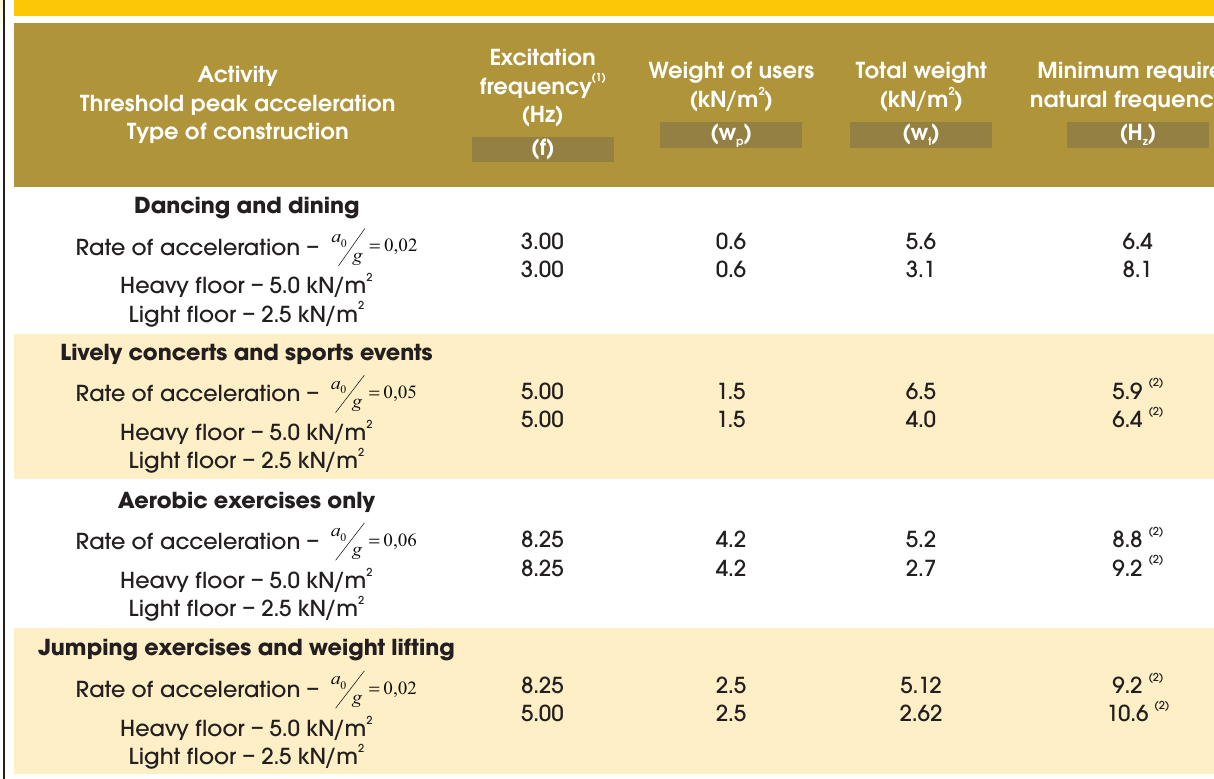
Table 5.3 – Application of equation 5.31 for rhythmic activities